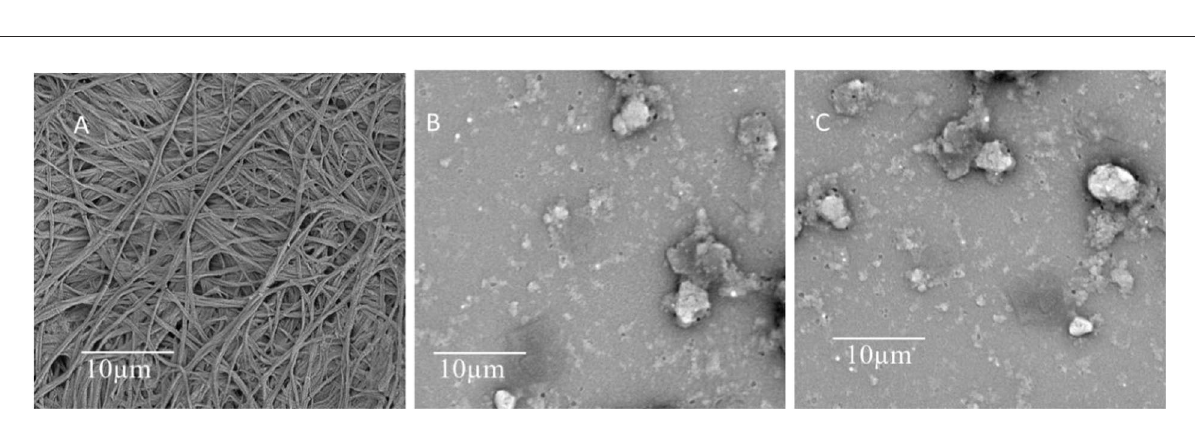
FIGURE3 The internal images of (A) original kombucha cellulose. (B) Kombucha cellulose hydrolysates produced via enzymatic treatment. (C) Kombucha cellulose hydrolysates produced via microwave-intensified enzymatic